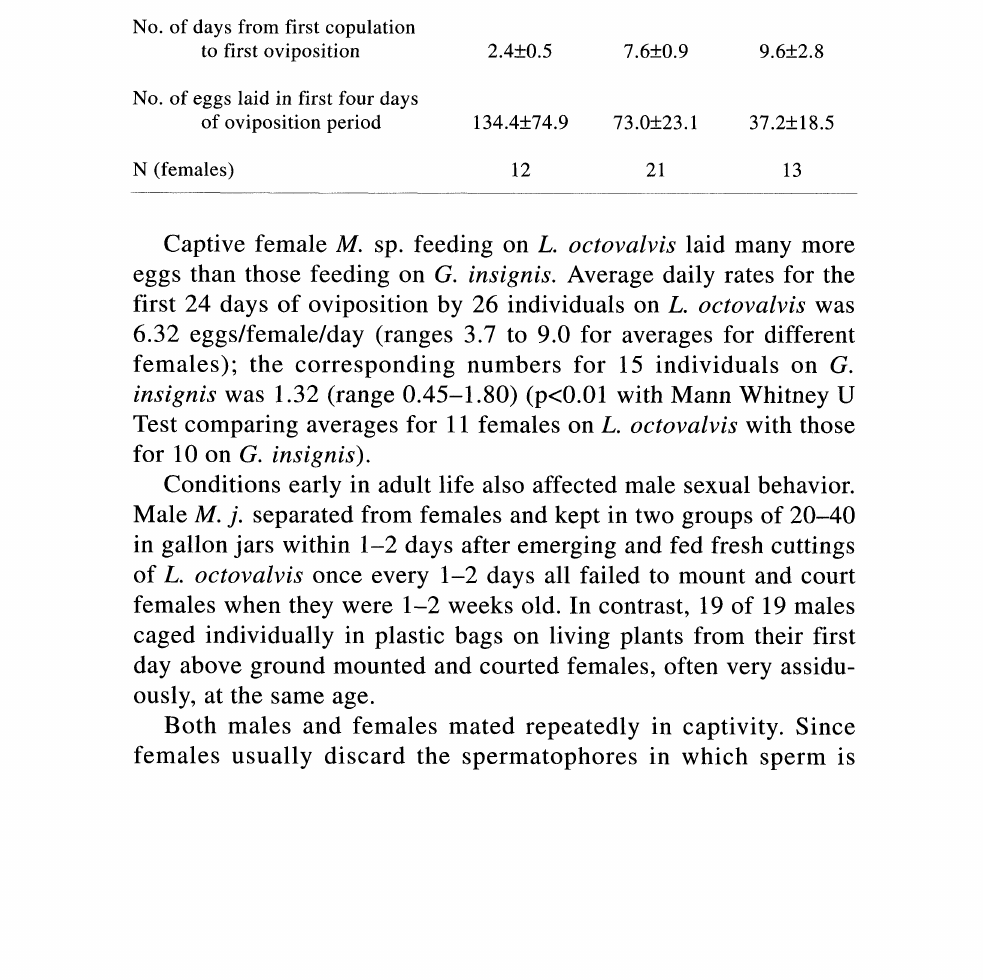
Table 4. Effect of conditions in early life on length of period before oviposition began in female M. jamaicensis, and on rate of egg production during the first four days of oviposition. Condition A: female kept on tender leaves of L. octovalvis plant from first day to adult life; Condition B: female kept in petri dish with moist paper towel and supplied with one newly picked leaf of L. octovalvis each day; Condition C: as in B but without moist towel. Males were combined with females, allowed a single copulation, then removed 1-2 hrs after copulation ended on the first day of mating. Similar matings were staged a day later, and, in conditions